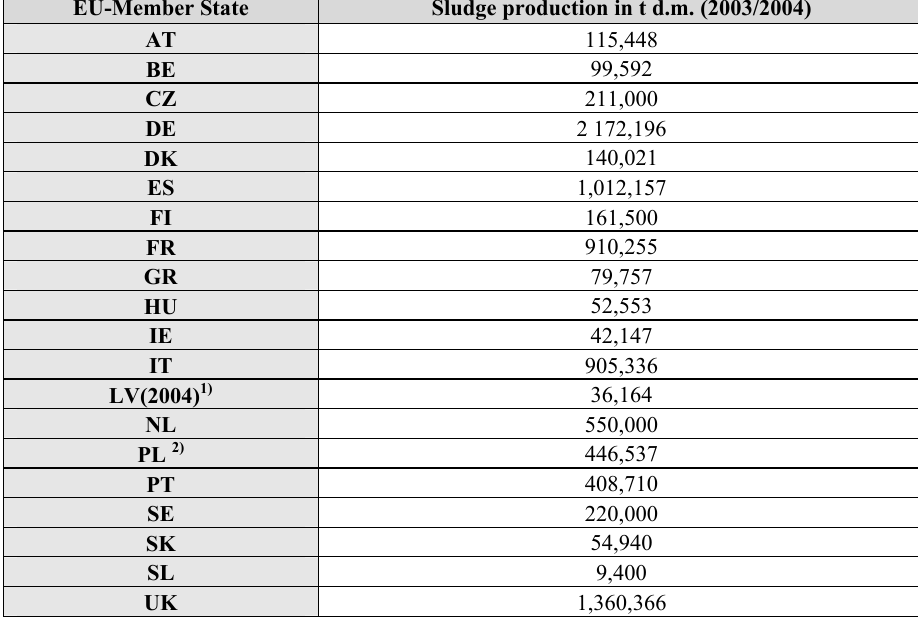
Table 39: Sewage sludge production in the EU in t d.m. in 2003/2004 [if not indicated otherwise: Schmelz, 2007 [jb20] ] EU-Member State Sludge production in t d.m.